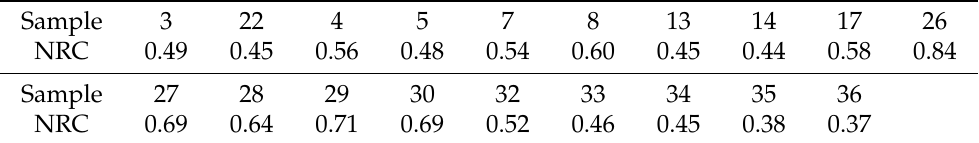
Table 2. NRC of the samples tested in this paper.